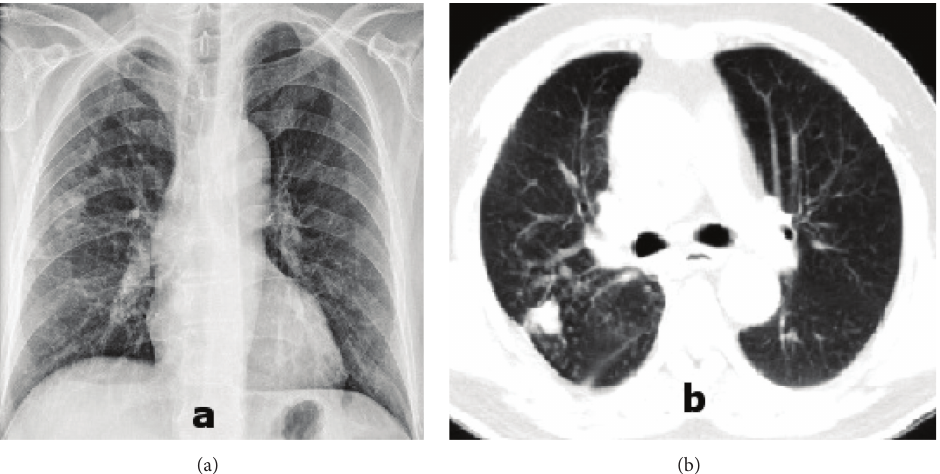
Figure 1: Pretreatment chest X-ray revealed a pulmonary nodule (a) and CT scan showed a nodule in the right upper lobe with tree-in-bud appearance in the adjacent parenchyma